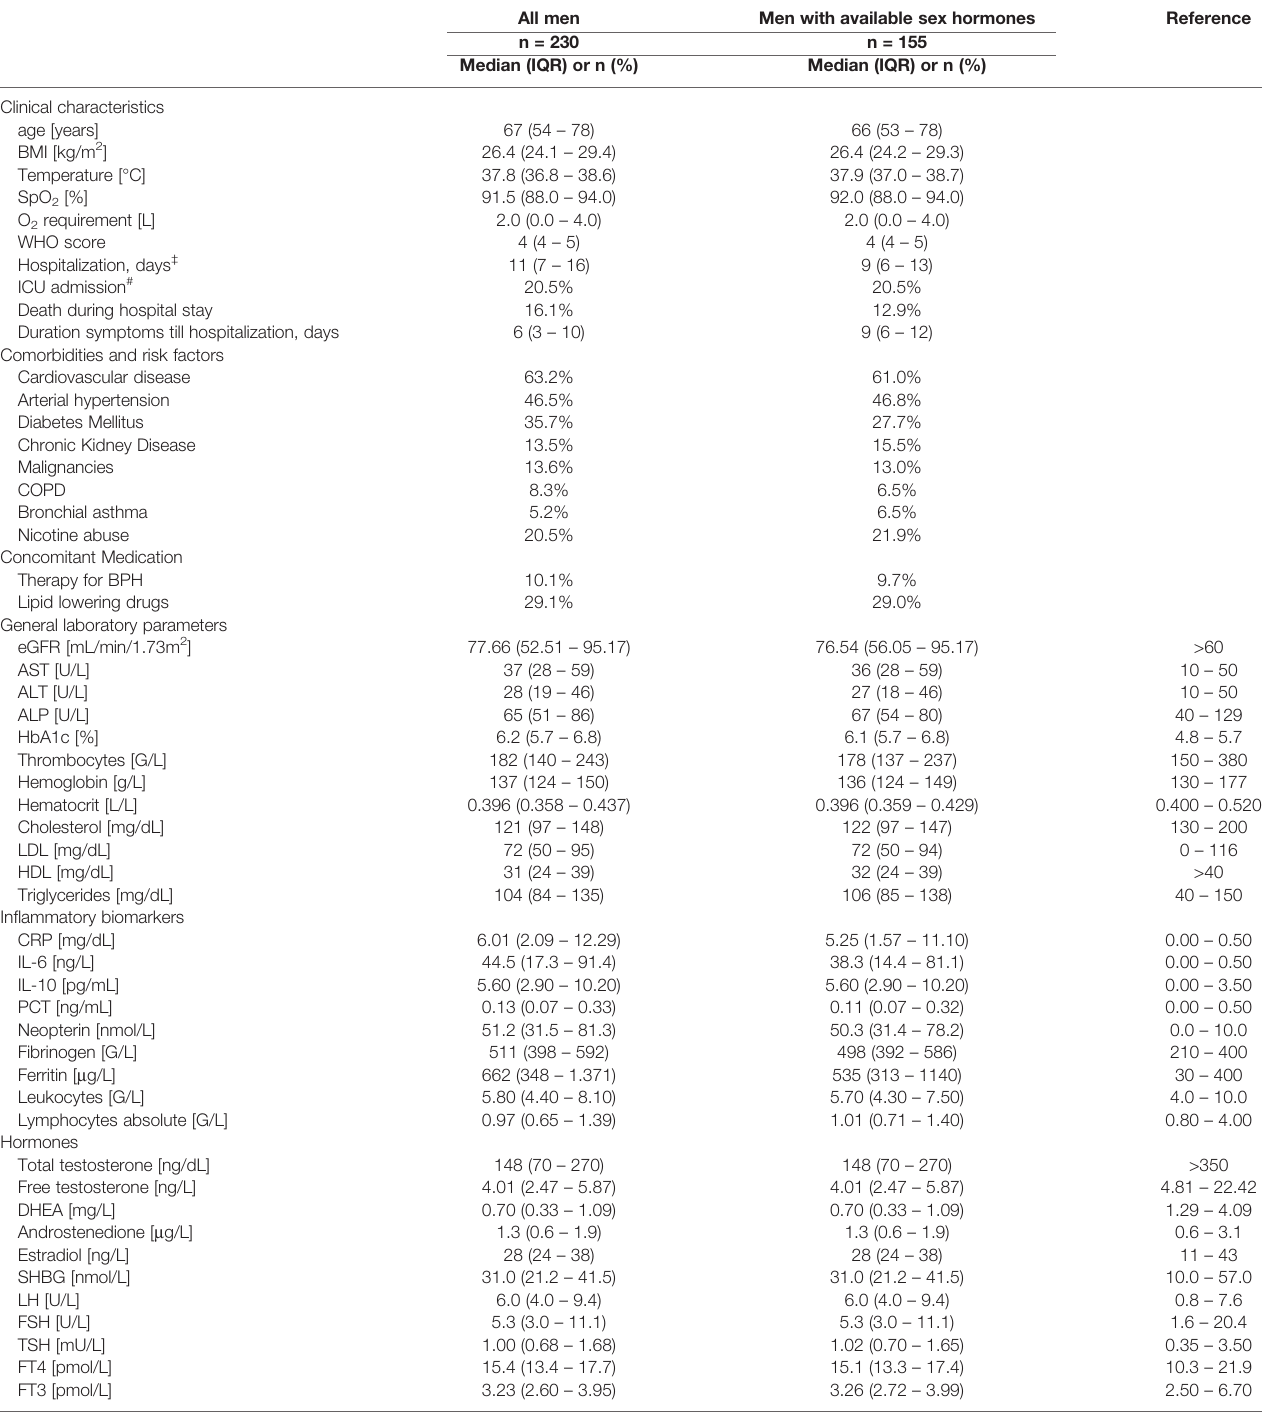
TABLE 1 | Baseline characteristics of men with corresponding reference